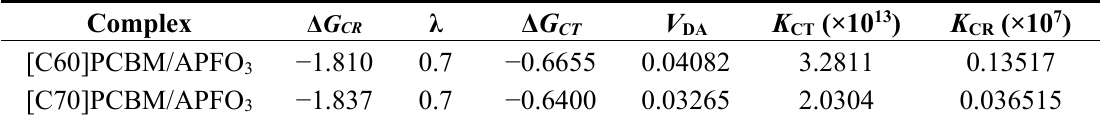
Table 4. Dynamic parameters for [C60]PCBM/APFO 3 and [C70]PCBM/APFO 3